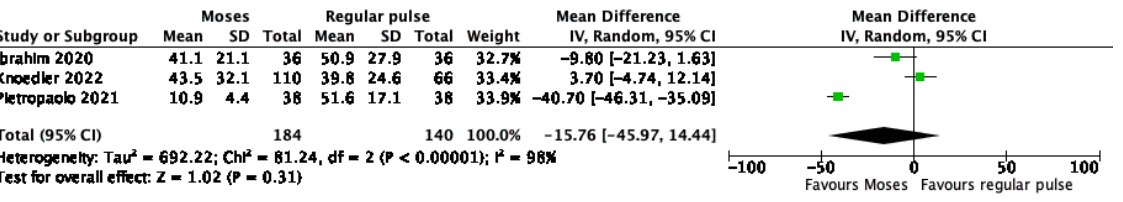
Figure 3. Forest plot of the meta-analysis comparing operative time between Moses versus regular pulse modulation [18,35,37].